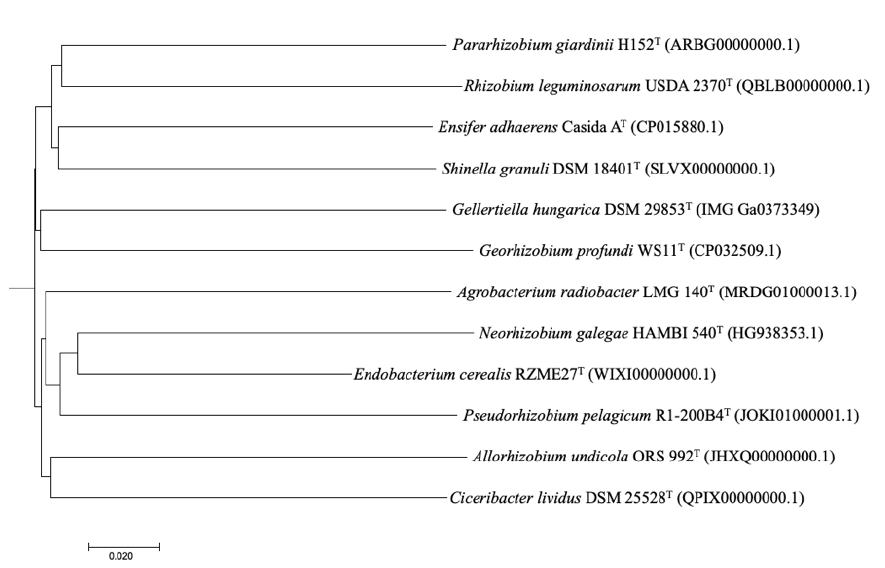
Figure 3. Whole genome based phylogenomic tree constructed with the Genome-BLAST Distance Phylogeny method (GBDP) tool and retrieved from the TYGS website. The tree was inferred with FastME 2.1.6.1 from GBDP distances calculated from genome sequences. The branch lengths are scaled in terms of GBDP distance formula d 5 .